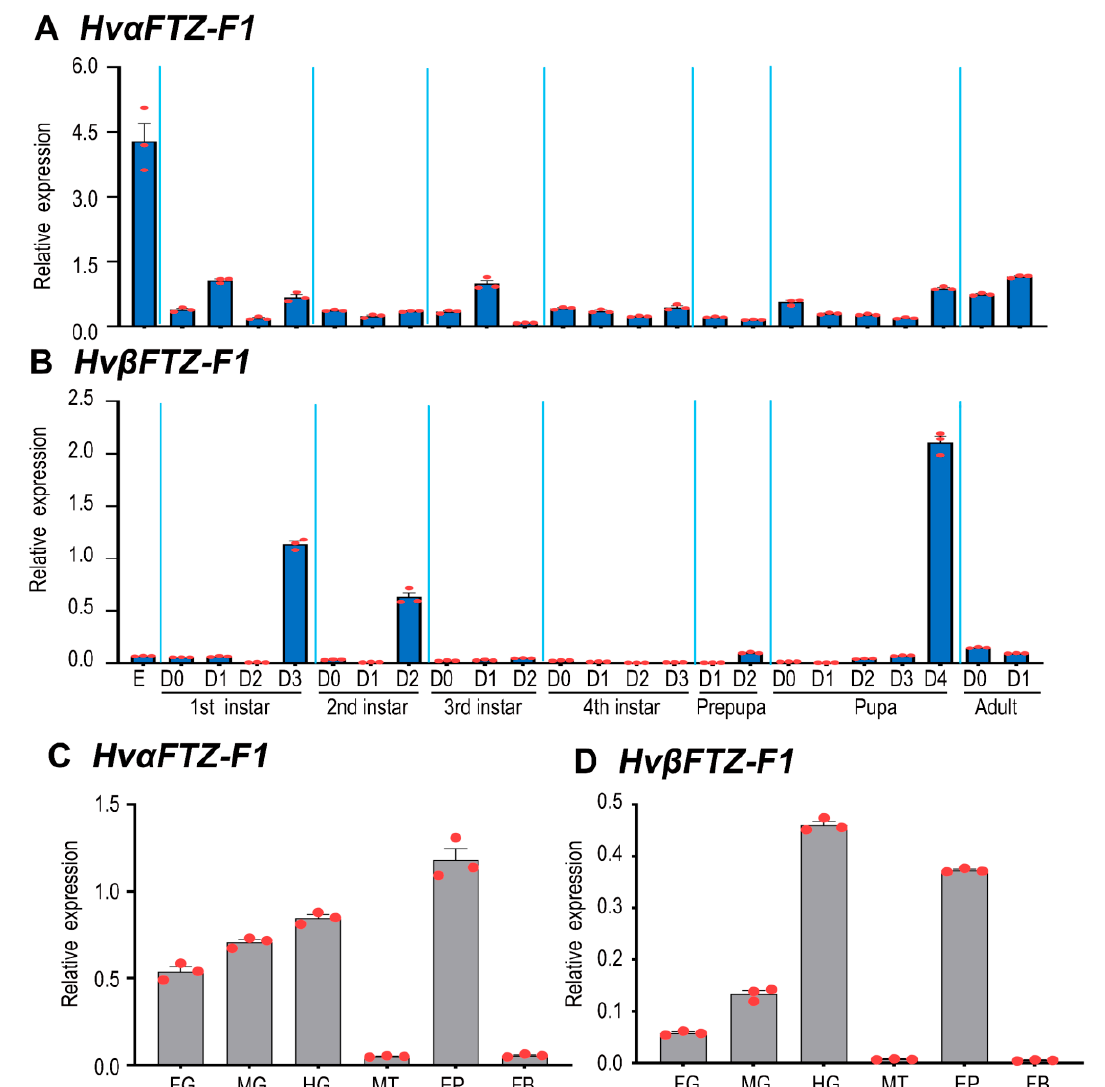
Figure 3. Temporal ( A , B ) and tissue ( C , D ) expression of Hv α FTZ-F1 and Hv β FTZ-F1 in Henosepi- lachna vigintioctopunctata . For temporal expression analysis, RNA templates were derived from eggs (3 days old), the larvae from the first to the fourth instars, prepupae, pupae and adults. (D0) indicated newly ecdysed larvae or pupae, or newly emerged adults. For tissue expression analysis, the relative transcripts were measured in the foregut (FG), midgut (MG), hindgut (HG), Malpighian tubules (MT), epidermis (EP) and fat body (FB) of the 2-day-old fourth-instar larvae. For each sample, 3 independent pools of 20–30 individuals were measured in technical triplicate using qRT-PCR. The values were calculated using the 2 −Δ CT method. Three biological replicates were marked with red dots. The columns represent averages with vertical lines indicating SE. The tissue-specific expression profiles of Hv α FTZ-F1 and Hv β FTZ-F1 were tested in the 2-day-old fourth-instar larvae. Both transcripts were detectable in the foregut, midgut, hindgut, Malpighian tubules, epidermis and fat body. Either Hv α FTZ-F1 or Hv β FTZ-F1 was highly expressed in the epidermis and guts and lowly transcribed in the Malpighian tubules and fat body (Figure